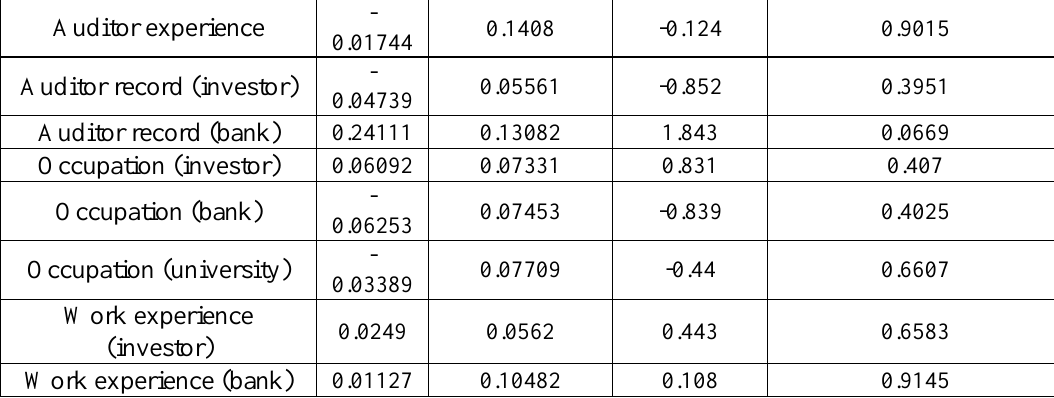
Table 14. Regression analysis of various factors in reducing audit expectation gap and